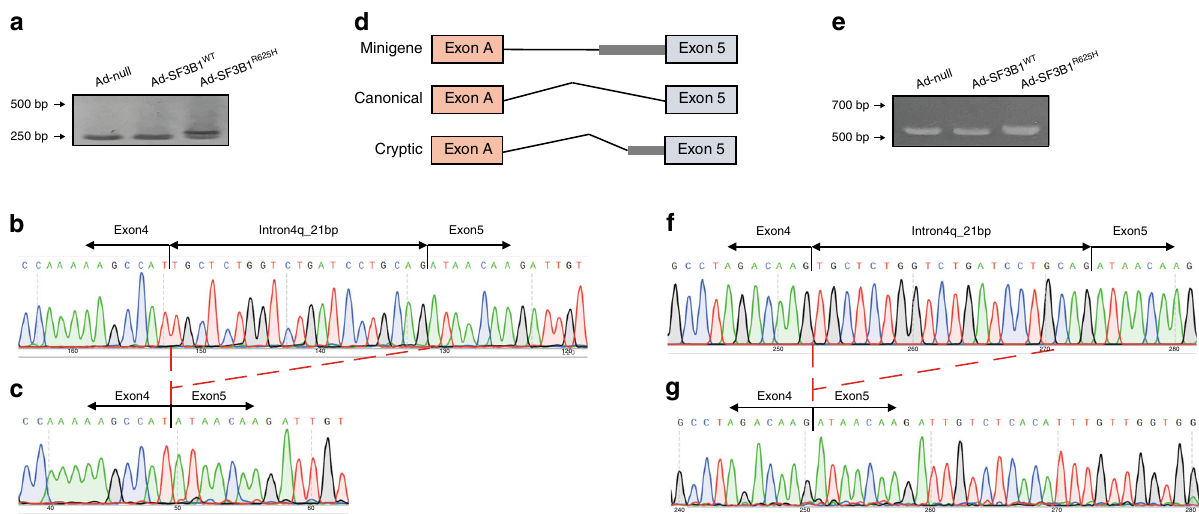
Fig. 4 Alternative splicing assays in minigene splicing reporters. a RT-PCR validation of aberrant splicing of ESRRG in MCF7 cells transduced with Ad-null, Ad-SF3B1 WT , and Ad-SF3B1 R625H , respectively. The higher band corresponds to the cryptic ESRRG transcript and the lower band corresponds to the canonical ESRRG transcript. b , c Sanger sequence of gel-puri fi ed fragment showing the aberrant ESRRG transcript in SF3B1 R625H cells b , the canonical ESRRG transcript in SF3B1 WT cells c . The red dotted lines indicate the location of 21 nucleotides. d Structure of minigene splicing reporters spanning the E5 region of ESRRG. e RT-PCR validation of aberrant splicing of ESRRG in MCF7 cells co-transduced minigene reporter with Ad-null, Ad-SF3B1 WT and Ad-SF3B1 R625H , respectively. The higher band corresponds to the cryptic ESRRG transcript and the lower band corresponds to the canonical ESRRG transcript. f , g Sanger sequence of gel-puri fi ed fragment showing the aberrant ESRRG transcript in SF3B1 R625H cells f , the canonical ESRRG transcript in SF3B1 WT cells g